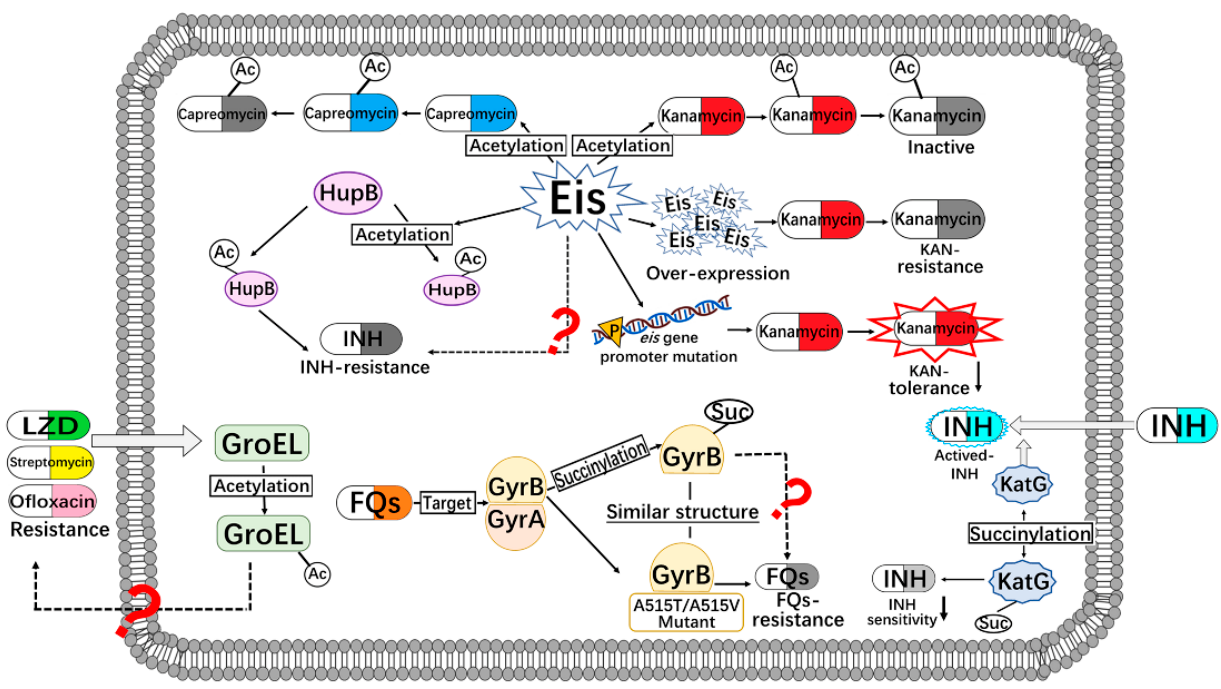
Figure 1. Connections of anti-tuberculosis drugs resistance and protein acylation in MTB. Ac, acetyla- tion; Eis, enhanced intracellular survival protein; FQs, fluoroquinolones; GyrA/B, gyrase subunit A/B protein, INH, isoniazid; KAN, kanamycin; LZD, linezolid; Suc,